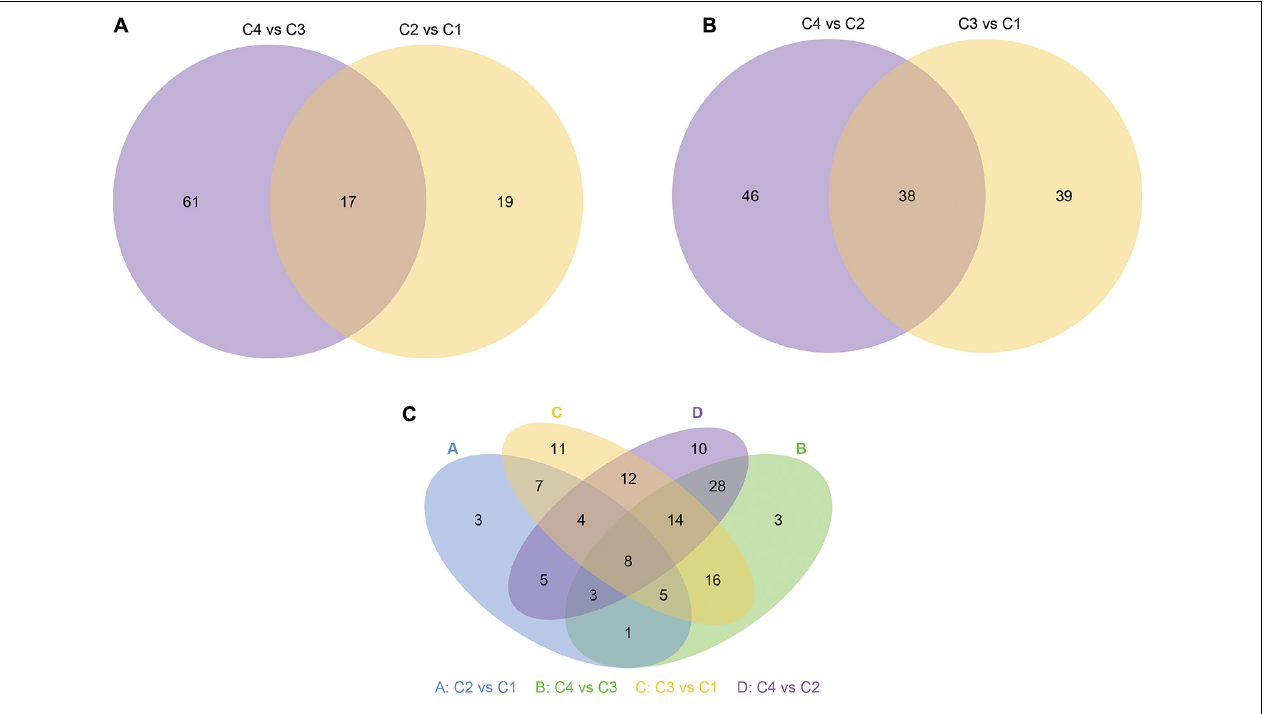
FIGURE 14 | Venn diagram of differential miRNA. The large circles represent each comparison combinations, and the sum of the number in each large circle represents the total number of differential miRNAs from the comparison combinations, and the overlapping portions of the circles represent the number of common differential miRNAs between the combinations. (A) Venn diagram of differential miRNA between C4 vs C3 and C2 vs C1 groups. (B) Venn diagram of differential miRNA between C4 vs C2 and C3 vs C1 groups. (C) Venn diagram of differential miRNA in all groups. C1: BcL.1-25 , C2: BcL.1-4 , C3: BcL.2-25 , C4: BcL.2-4 .